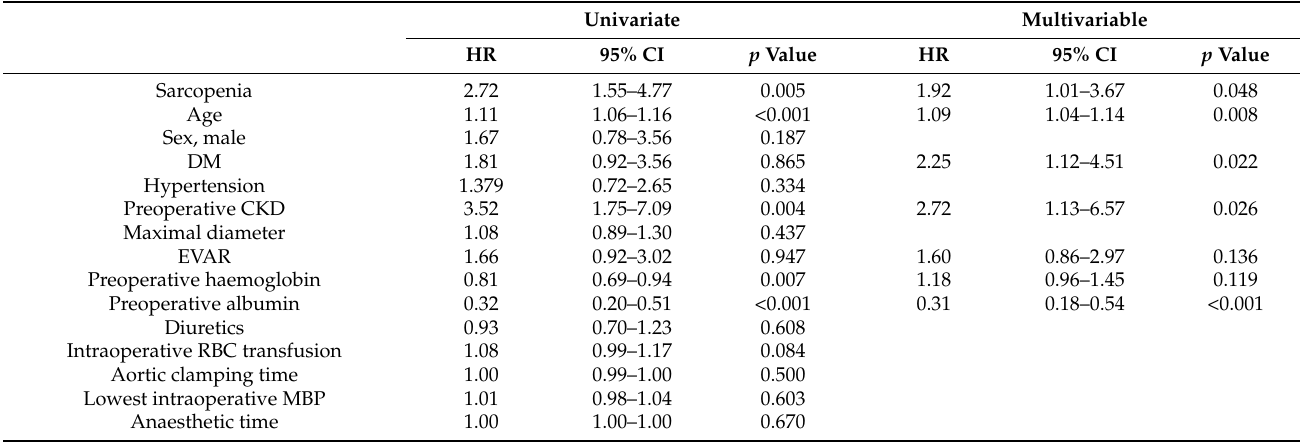
Table 3. Cox proportional hazard analysis of risk factors associated with overall mortality.